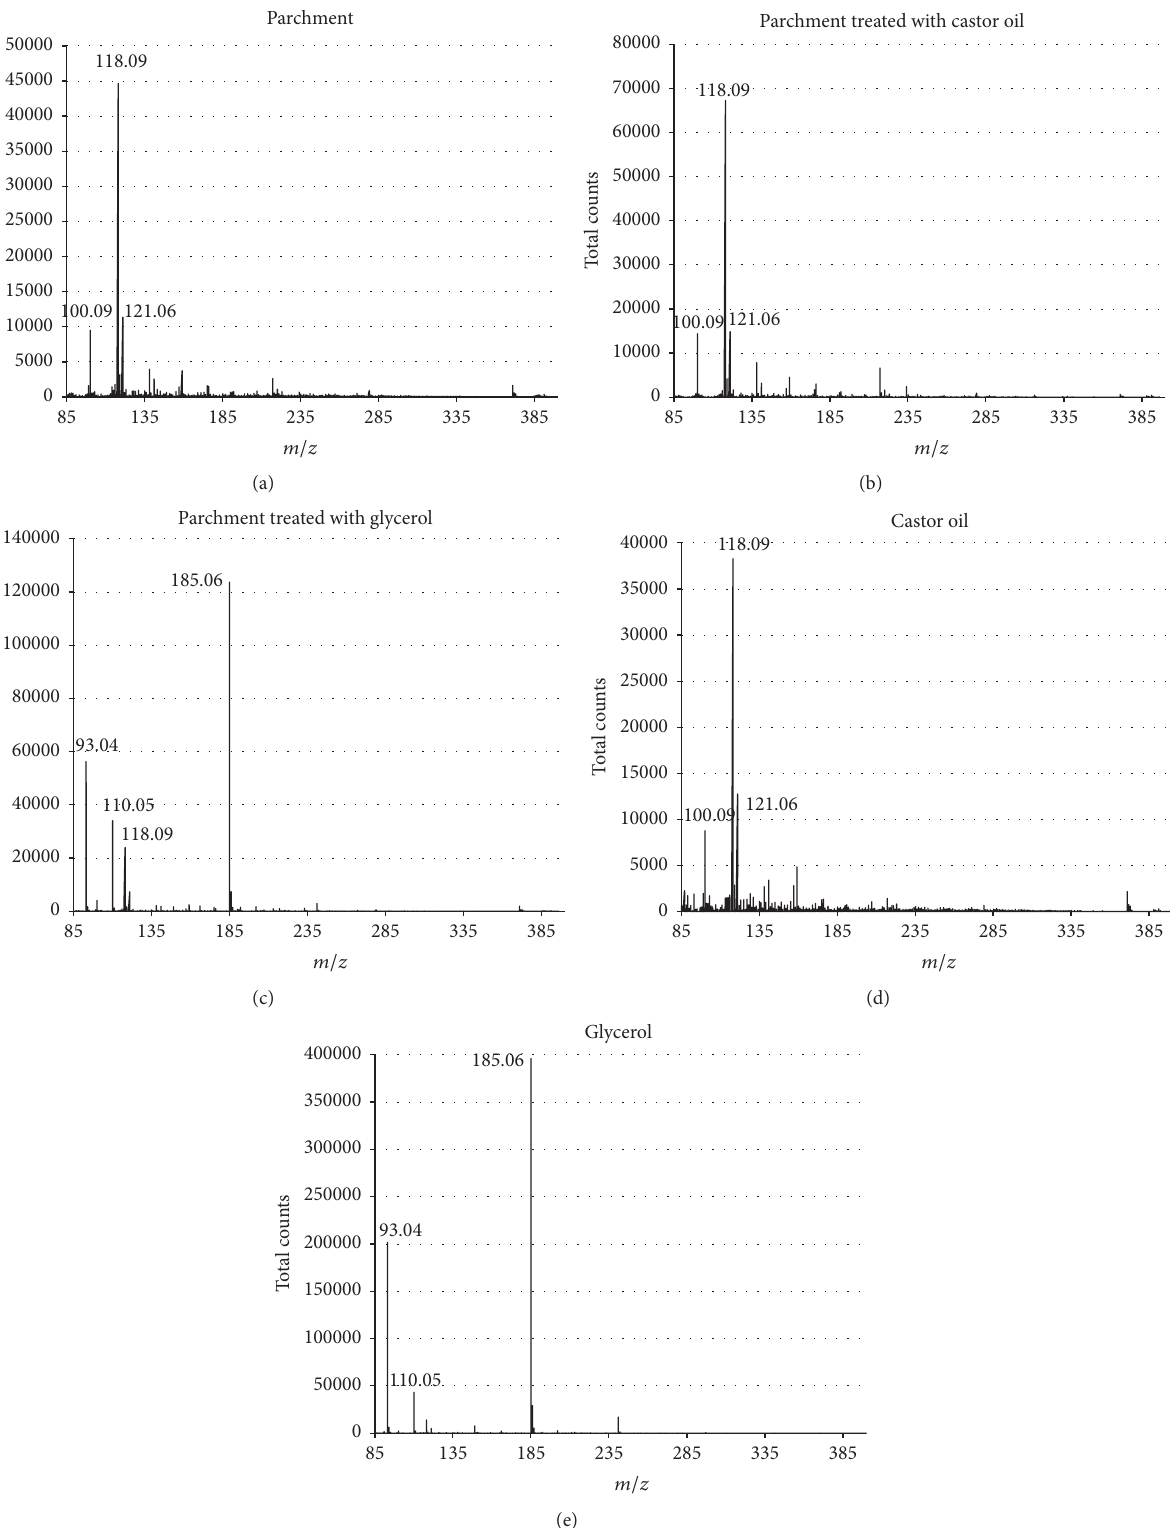
Figure3:(a)Massspectrumofuntreatedparchment,(b)massspectrumofparchmenttreatedwithcastoroil,(c)massspectrumofparchment treated with glycerol with the signal at 𝑚/𝑧 93.049 (protonated: M+H+) and 185.063 (dimeric ions: M+M+H+), (d) mass spectrum of castor oil standard, and (e) mass spectrum of glycerol